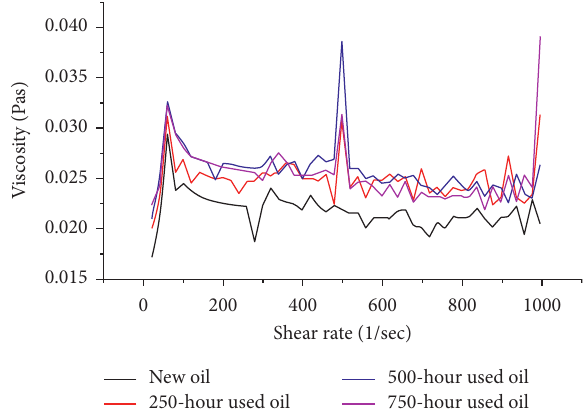
Figure 16: A combined graph of change in viscosity with shear rate at 60 ° C.